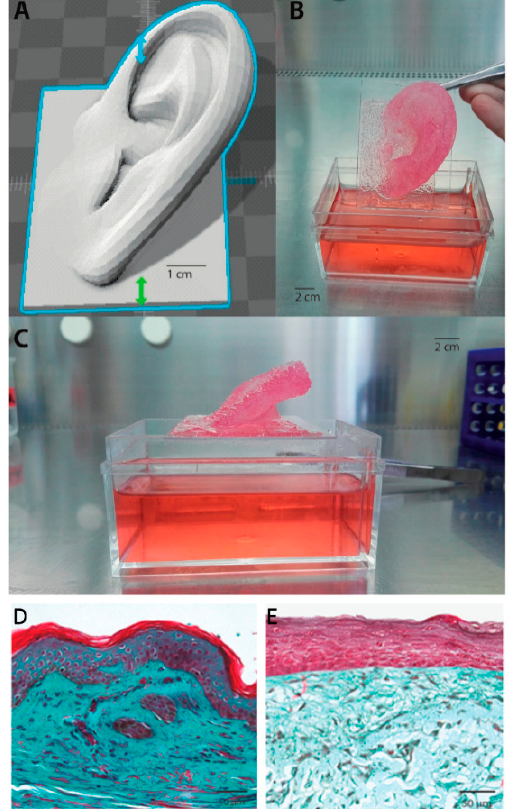
Figure 4. 3D Bioprinted organ. ( A ) 3D computer-aided design (CAD). ( B , C ) 3D bioprinted adult- sized ear constituted of fibroblast containing dermal bioink. As can be seen, the complex architecture was retained during culture (i.e., immersion in Dulbecco’s Modified Eagle Medium (DMEM) culture medium). ( D ) Mason’s Trichrome staining of human skin. ( E ) Mason’s Trichrome staining